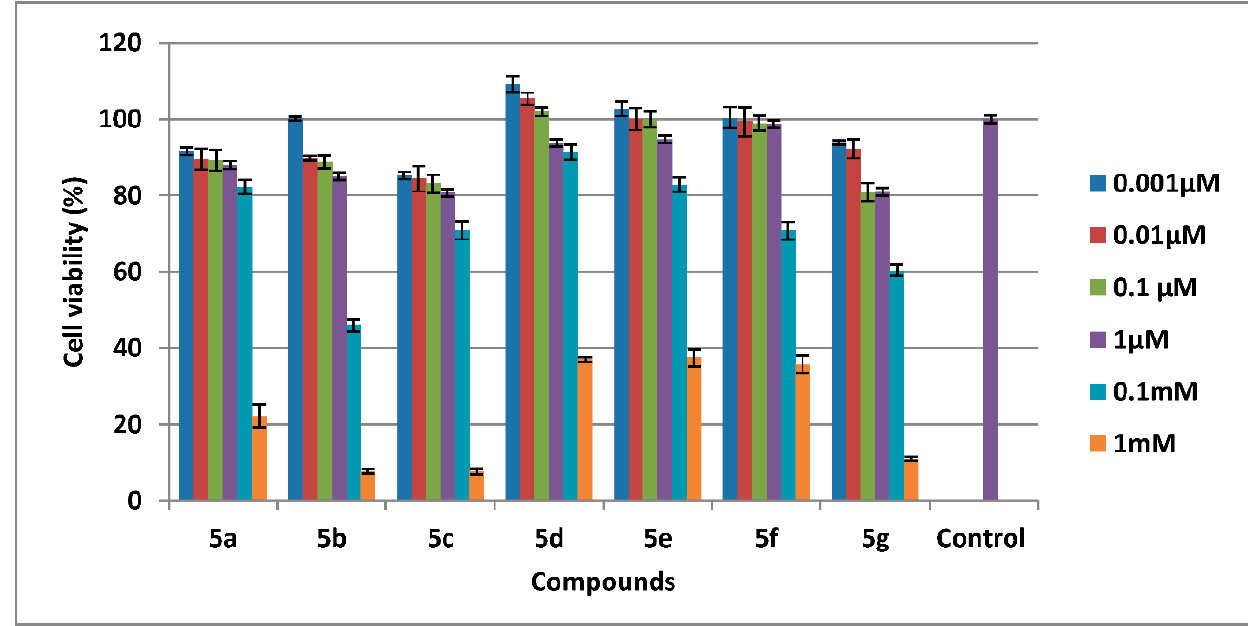
Figure 3. Cell viability of L929 fibroblasts cultured with pyrazolo-benzimidazole derivatives after 48h of experimentation, evaluated by MTT assay.